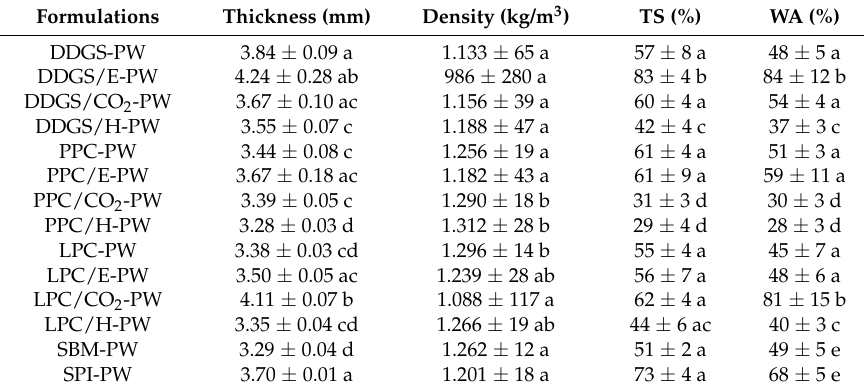
Table 6. Dimensional Stability properties of composites soaked in distilled water for 24 h. Means and standard errors are presented; treatment having different letters in the same columns were significant ( p ≤ 0.05).